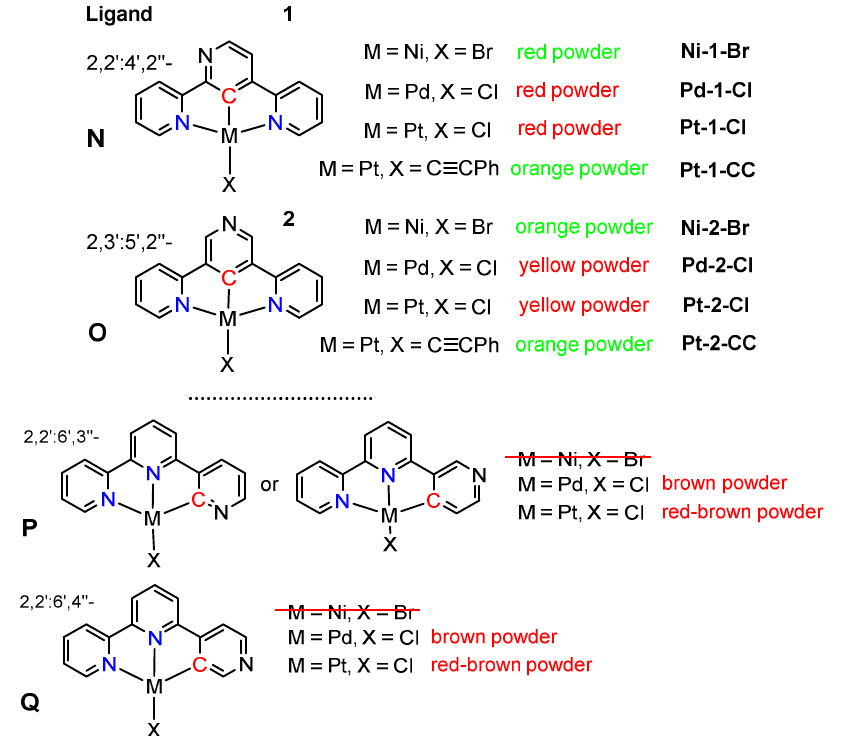
Table 1. Overview of aTempted complex syntheses using 2,2′:6′,3″- and 2,2′:6′,4″-terpy ligands. Terpy